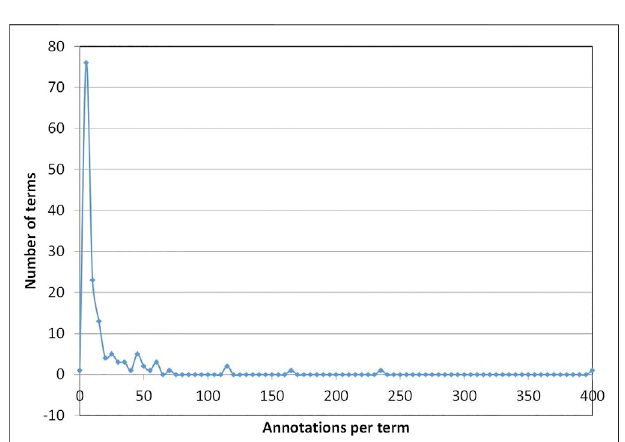
FIGURE 5 | Annotation counts per ECO